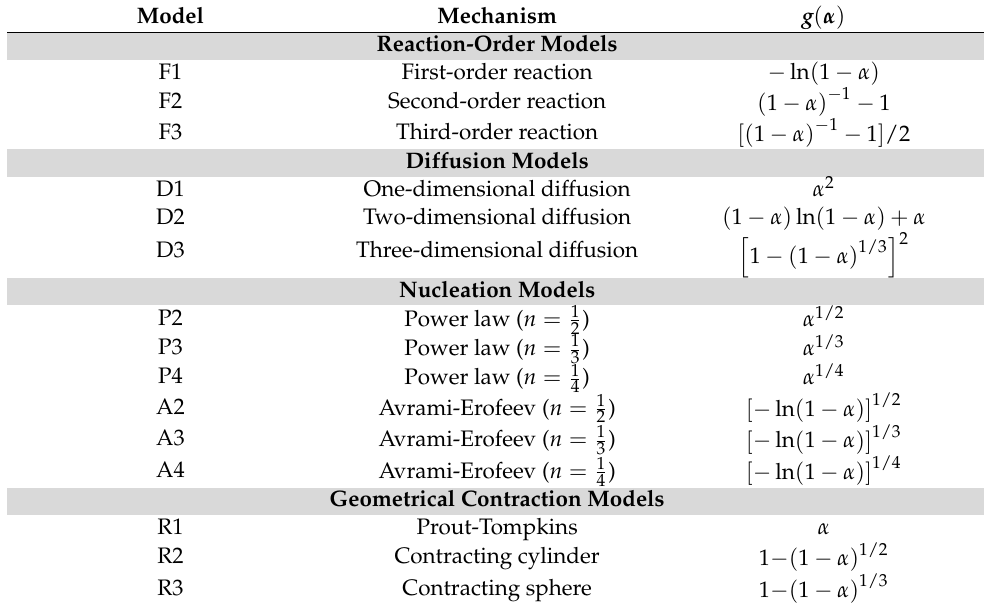
Table 2. List of the most used solid-state reaction